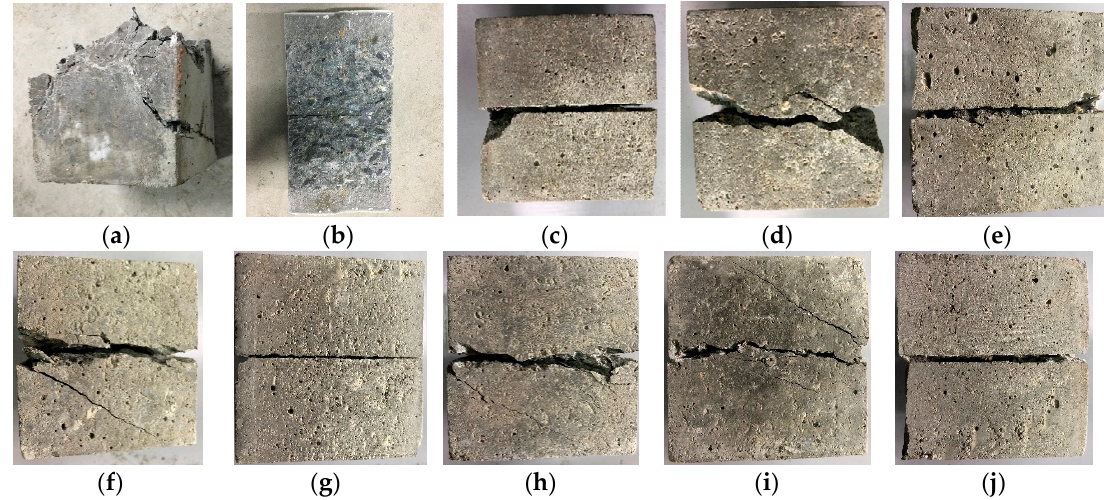
Figure 2. The shear failure modes of different experiments: ( a ) Uniaxial SCC-C; ( b ) Uniaxial splitting tensile SCC-T; ( c ) Shear failure surface SCC-CS-0; ( d ) Lateral shear failure surface SCC-CS-0; ( e ) Shear failure surface SCC-CS-2; ( f ) Lateral shear failure surface SCC-CS-2; ( g ) Shear failure surface SCC-CS-6; ( h ) Lateral shear failure surface SCC-CS-6; ( i ) Shear failure surface SCC-CS-10; ( j ) Lateral shear failure surface SCC-CS-1.